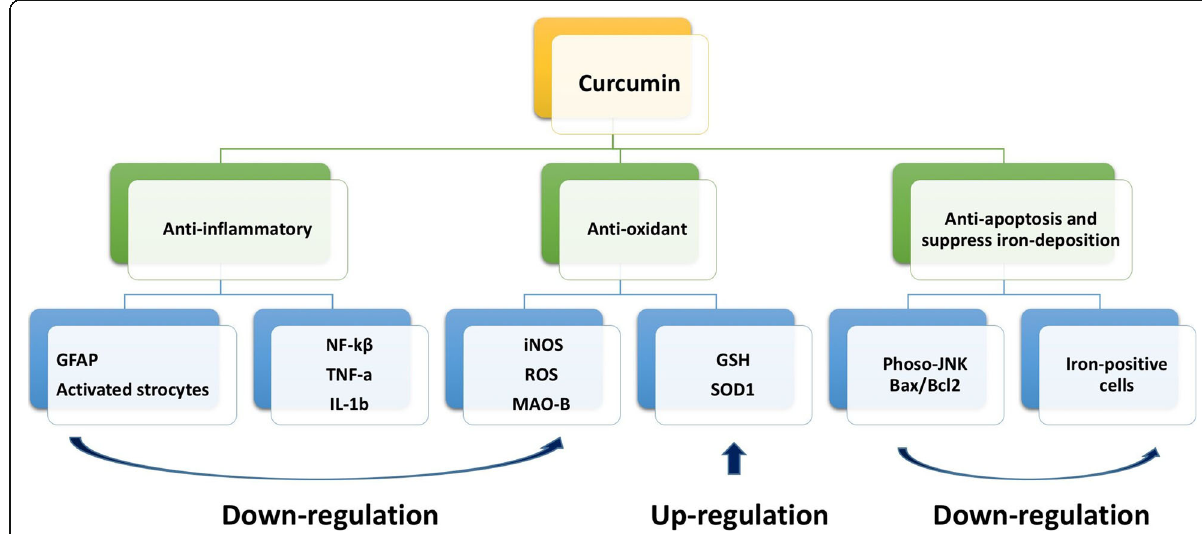
Fig. 3 Schematic representation the neuroprotective mechanisms of curcumin in treating PD. Curcumin was shown to improve neurological function and exhibited anti-oxidant, anti-inflammatory and anti-apoptosis properties, as a neuroprotective agent used in